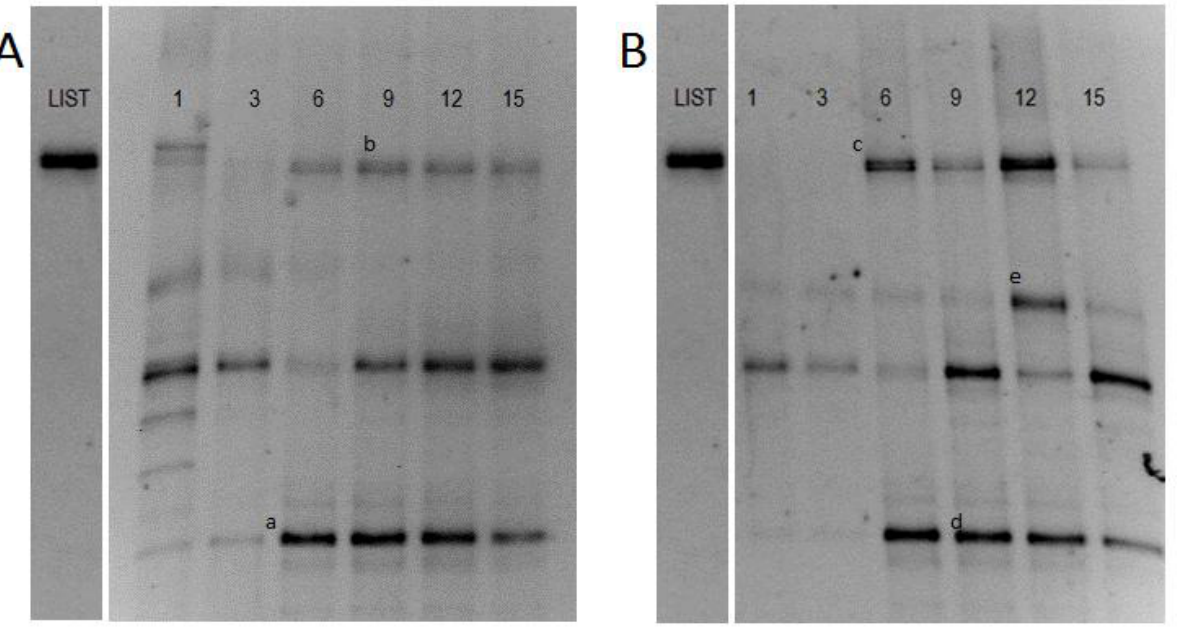
Figure 2. Denaturing Gradient Gel Electrophoresis (DGGE) profiles of PCR product obtained from samples that were not challenged with L. monocytogenes ( A ) and samples that were challenged by L. monocytogenes ( B ) using a 40%–50% denaturing gradient. Listeria markers were used to show the migration pattern of L. monocytogenes . Bands indicated by letters were excised and sequenced: ( a ) and ( d ), B. thermosphacta (AY543029); ( b ), Staphylococcus spp. (HQ711532); ( c ), Staphylococcus spp. (HQ71153) and L. monocytogenes (FM242711); ( e ), L. curvatus